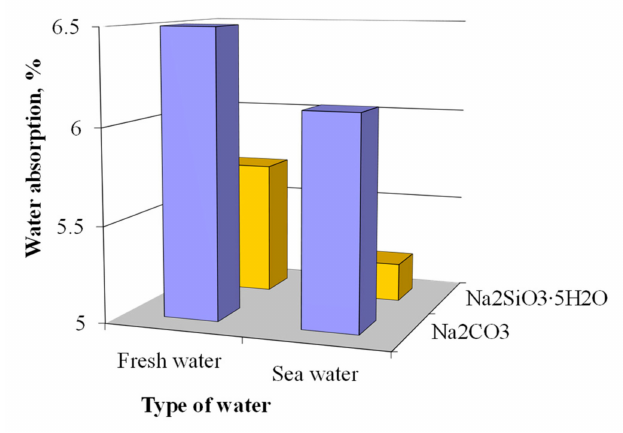
Figure 14. Water absorption of the plasticized concrete based on blast furnace cement.